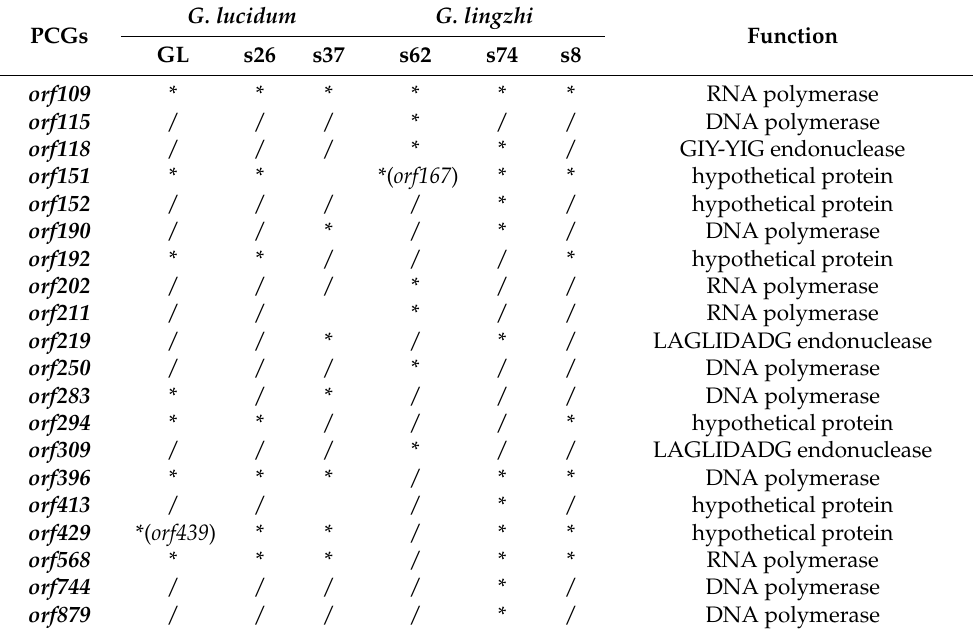
Table 1. Non-conserved protein-coding genes in the mitogenomes of Ganoderma lucidum and G. lingzhi